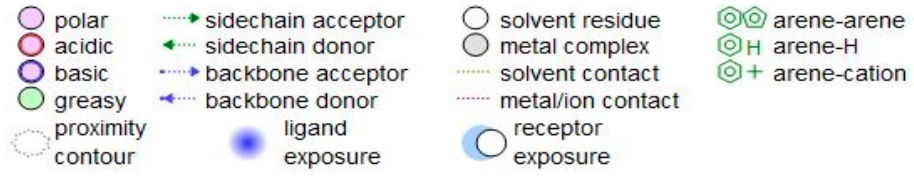
Figure 12. The representative key for the types of interaction between chitosan and